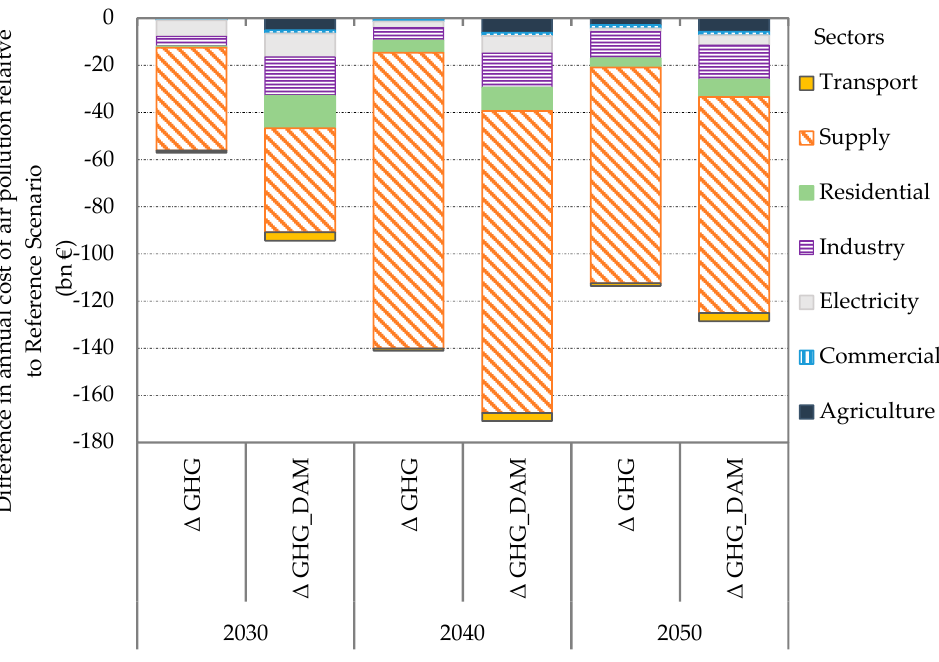
Figure 3. Difference in annual costs of air pollution relative to the reference scenario in the European Union (EU28, bn €2010).